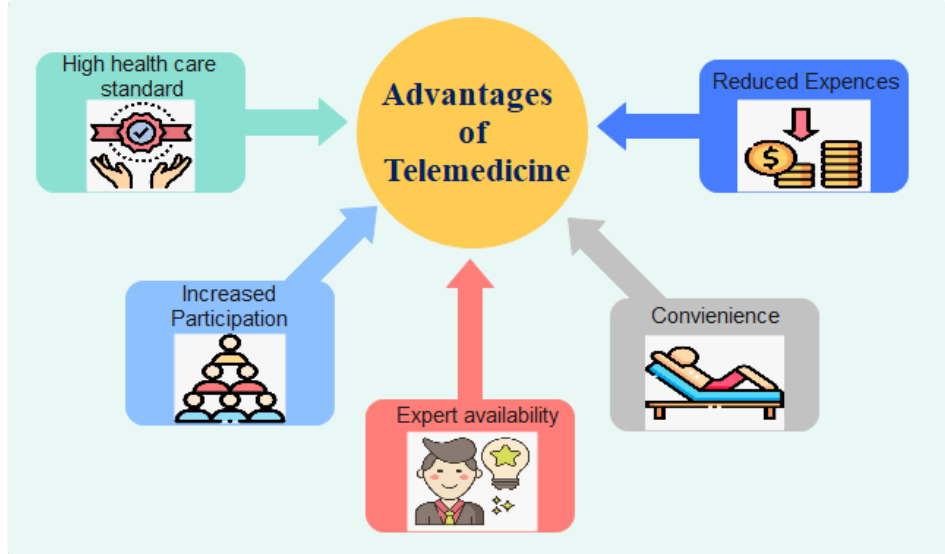
Figure 5. Advantages of